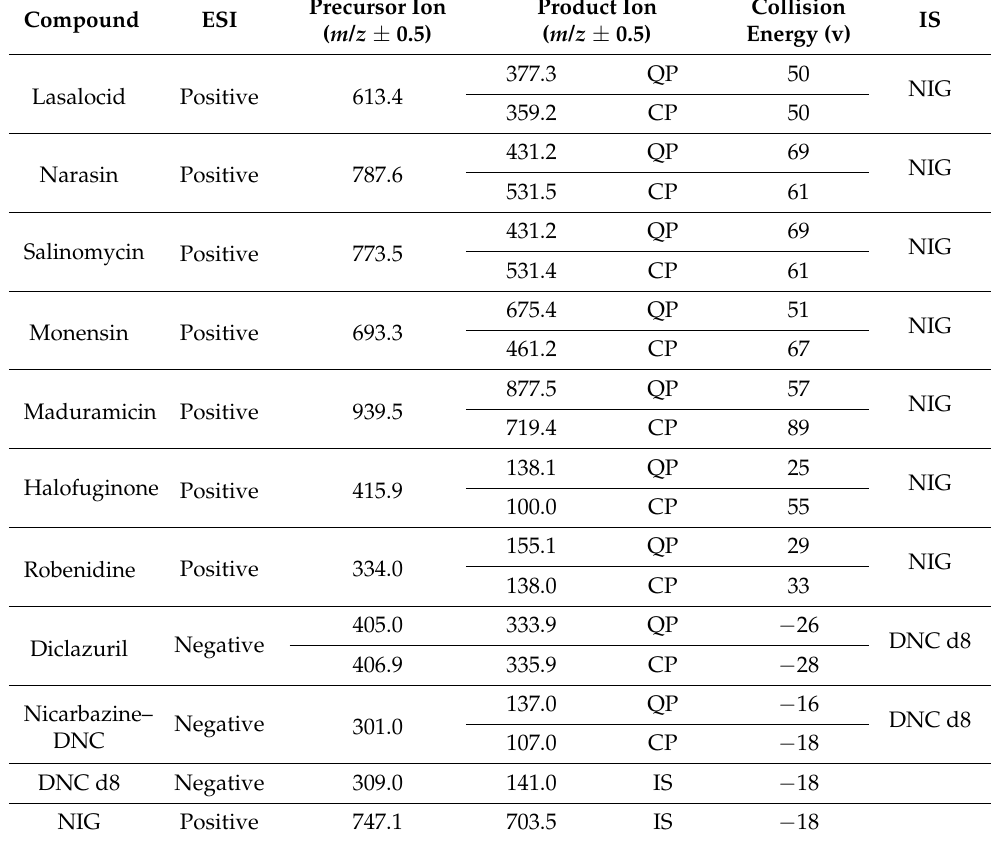
Table 1. MRM acquisition conditions for each compound and the corresponding IS.